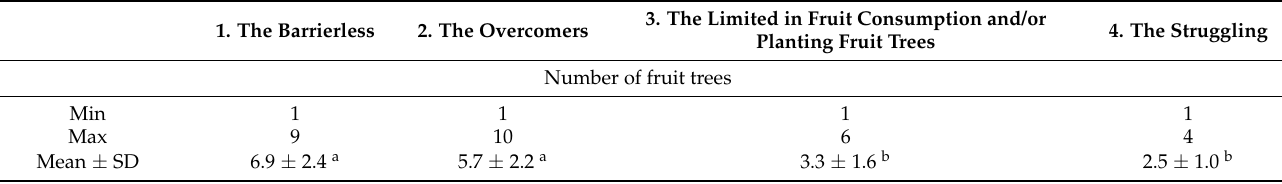
Table 5. Mean numbers of different types of fruit trees in the homestead per cluster